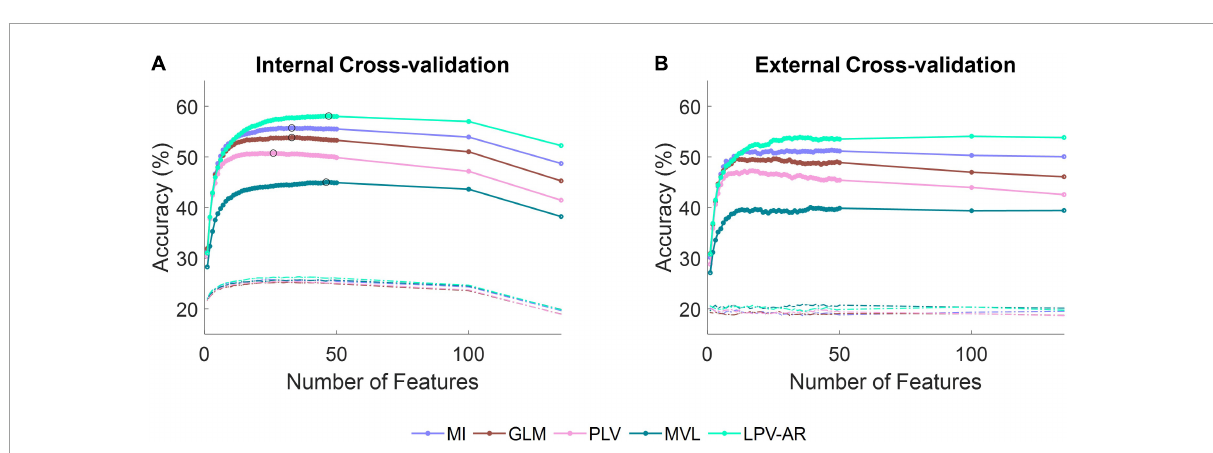
FIGURE6 Average accuracy over all participants for the five-class classification problem (i.e., hand open vs. palmar grasp vs. lateral grasp vs. pronation vs. supination) as a function of the number of features during (A) the internal cross-validation and (B) the external cross-validation step. Different line colors correspond to different CFC estimation methods. Dashed lines represent accuracy levels obtained by training the classifier on data with permuted labels. The theoretical chance accuracy level is 20%. In (A) , the maximum classification accuracy for each CFC method is indicated with a black circle.